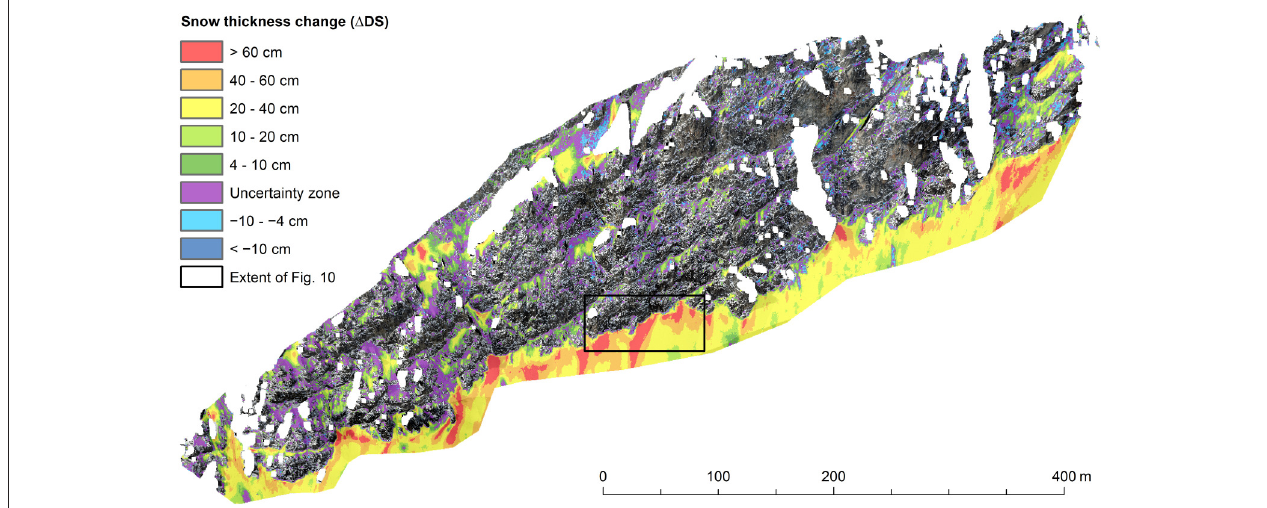
FIGURE 5 | Spatial distribution of the snow accumulation during the snowfall. The area in the black rectangle is shown in detail in Figure 10 . Most snow accumulated below the actual rock face. Within the rock face, 1 DS only reached high values locally. The spatial variability was high. The orientation of the rock face is similar to the view in Figure 1B .